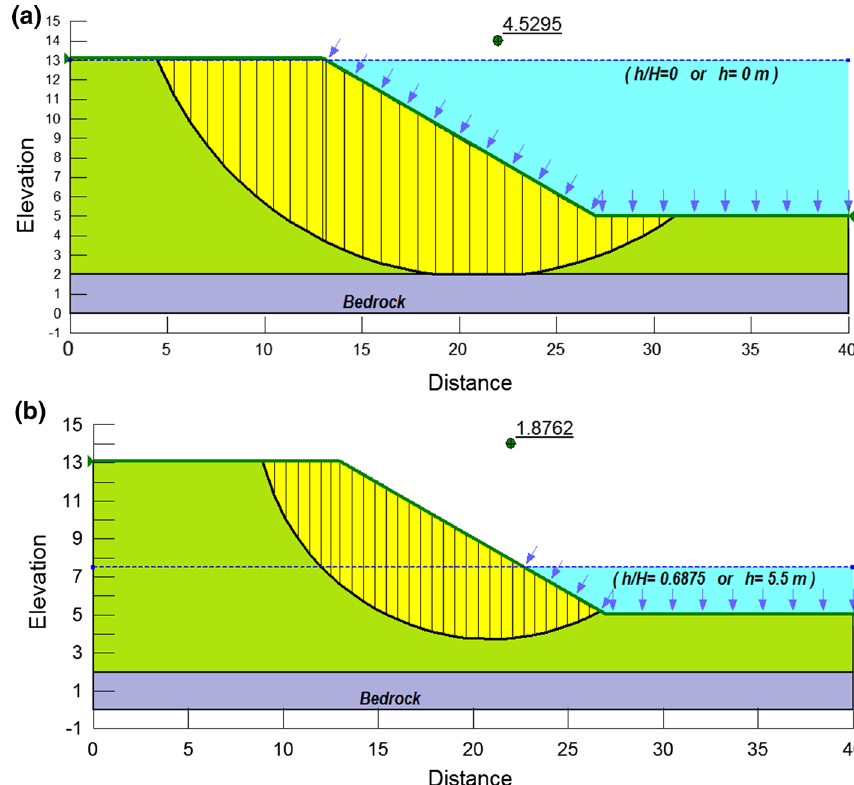
Fig. 11 a Slip circle type changes without water ◦ , surface drawdown � = 14 C = 25kN/m 2 , 𝛾 = 15kN/m 3 , = 0. 𝛽 = 30 ◦ , h b Slip circle H type changes with water ◦ , surface drawdown � = 14 C = 25kN/m 2 , 𝛾 = 15kN/m 3 , = 𝛽 = 30 ◦ , h H